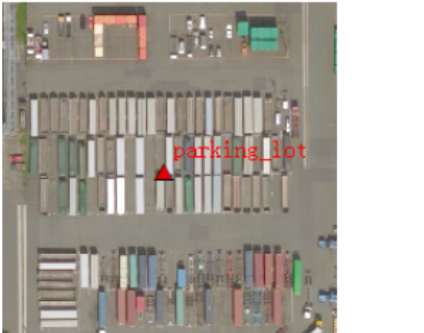
Figure 2. Multi-labeling in a small candidate area. Red annotations are the retention categories, and the yellow annotations should be deleted. The left side of the candidate area shows “highway”; “bus_stop”, and “bus_stop” should be removed, due to their small size and unclear recognition. The right side of the candidate area shows “bridge”; “city_building” should be removed due to its lack of salience and as it is smaller than the bridge. This may not be the case for another image, where city_building may be dominant.